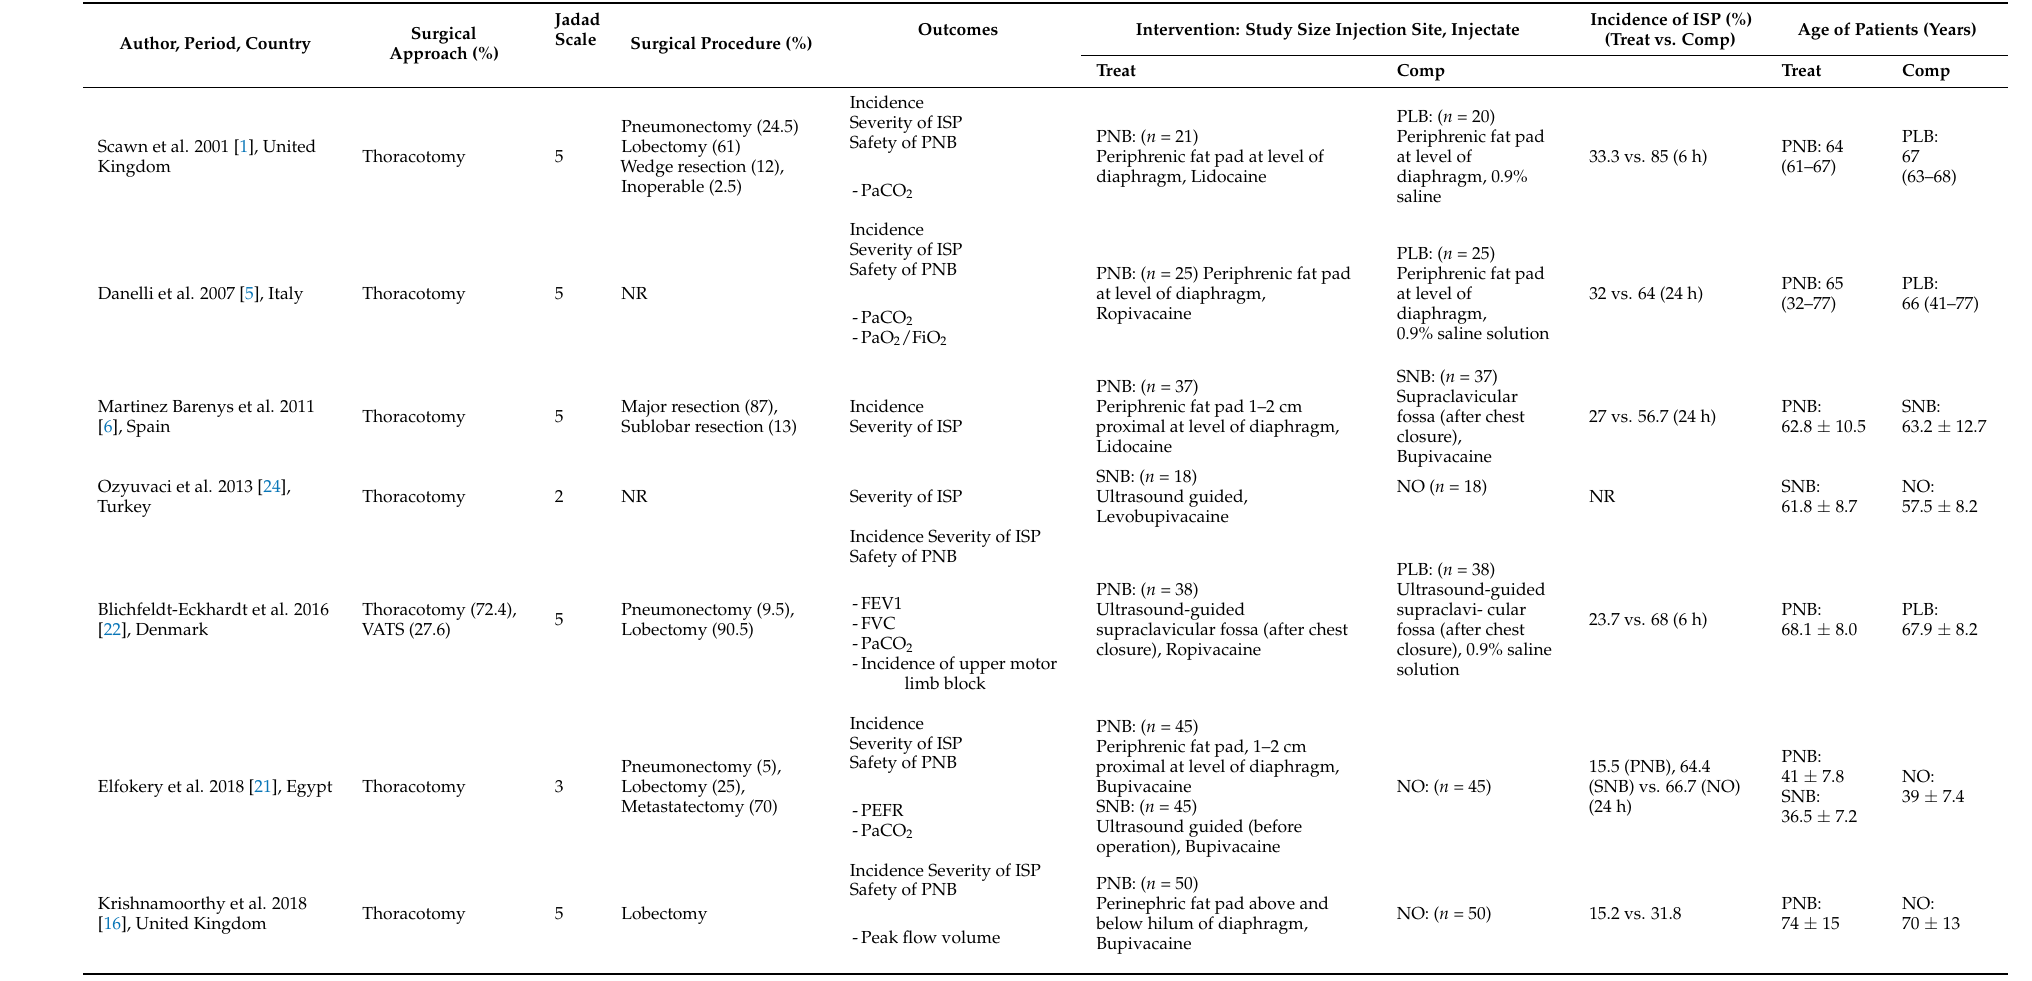
Table 1. Description of included